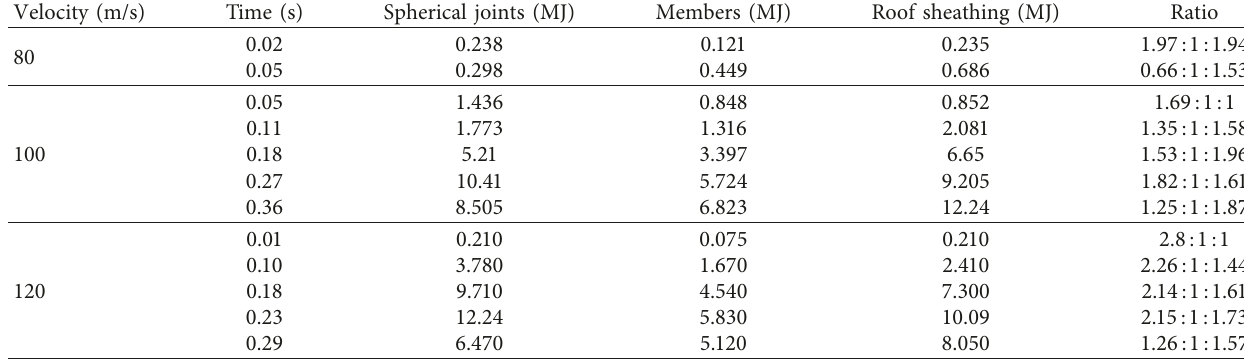
Table 6: Energy and contrast of ball nodes, bars, and roof panel under aircraft impact at different velocities. Velocity (m/s) Time (s) Spherical joints (MJ) Members (MJ) Roof sheathing